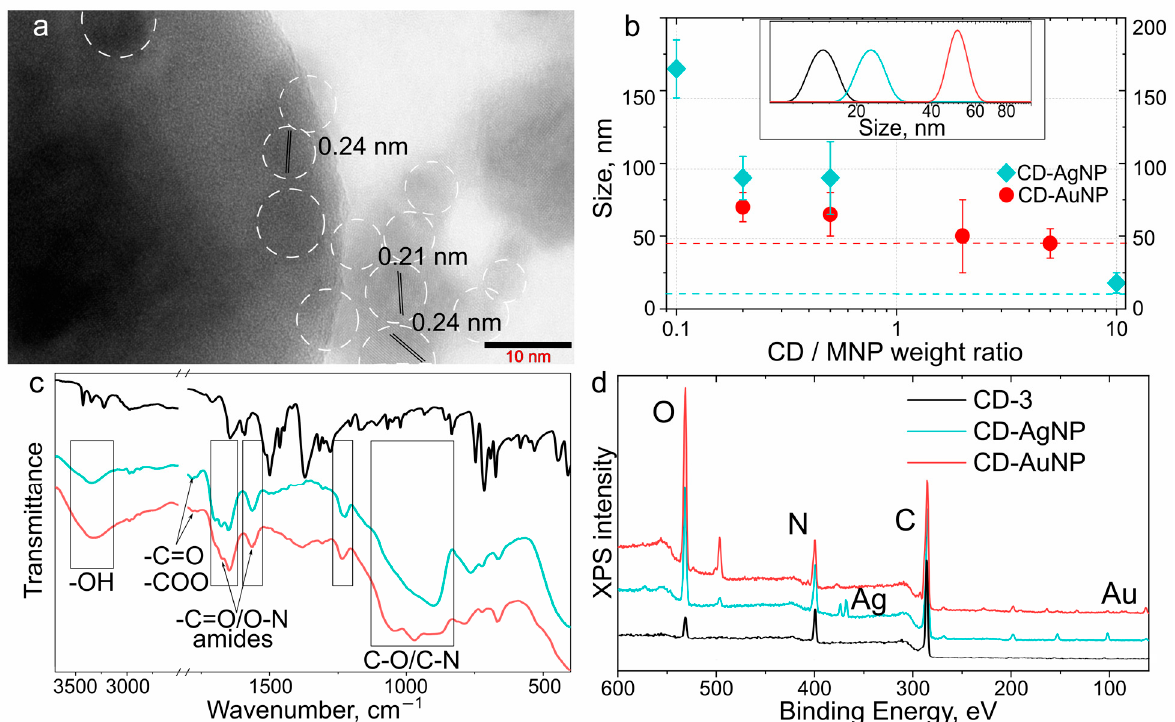
Figure 4. ( a ) TEM image of the CD–AuNP complex, with an indication of the interplanar distances attributed to CDs. CDs are highlighted by dashed circles. ( b ) Hydrodynamic diameters of the CD–AgNPs complexes (cyan diamonds) and CD–AuNP complexes (red circles) estimated from DLS measurements, as a function of the CD/MNP weight ratio. Dashed cyan and red lines indicate the values of hydrodynamic diameters of pristine AgNPs and AuNPs, respectively. Inset exemplifies typical size distribution curves determined by DLS for the CD-EDC/NHS conjugate (gray line), CD–AgNP complex (cyan line), and CD–AuNP complex (red line). ( c ) FTIR and ( d ) XPS full survey spectra of CD-3 (black line), CD–AgNP complex (cyan line), and CD–AuNP complex (red line). FTIR spectra of CD–AgNP and CD–AuNP complexes are shown in Figure